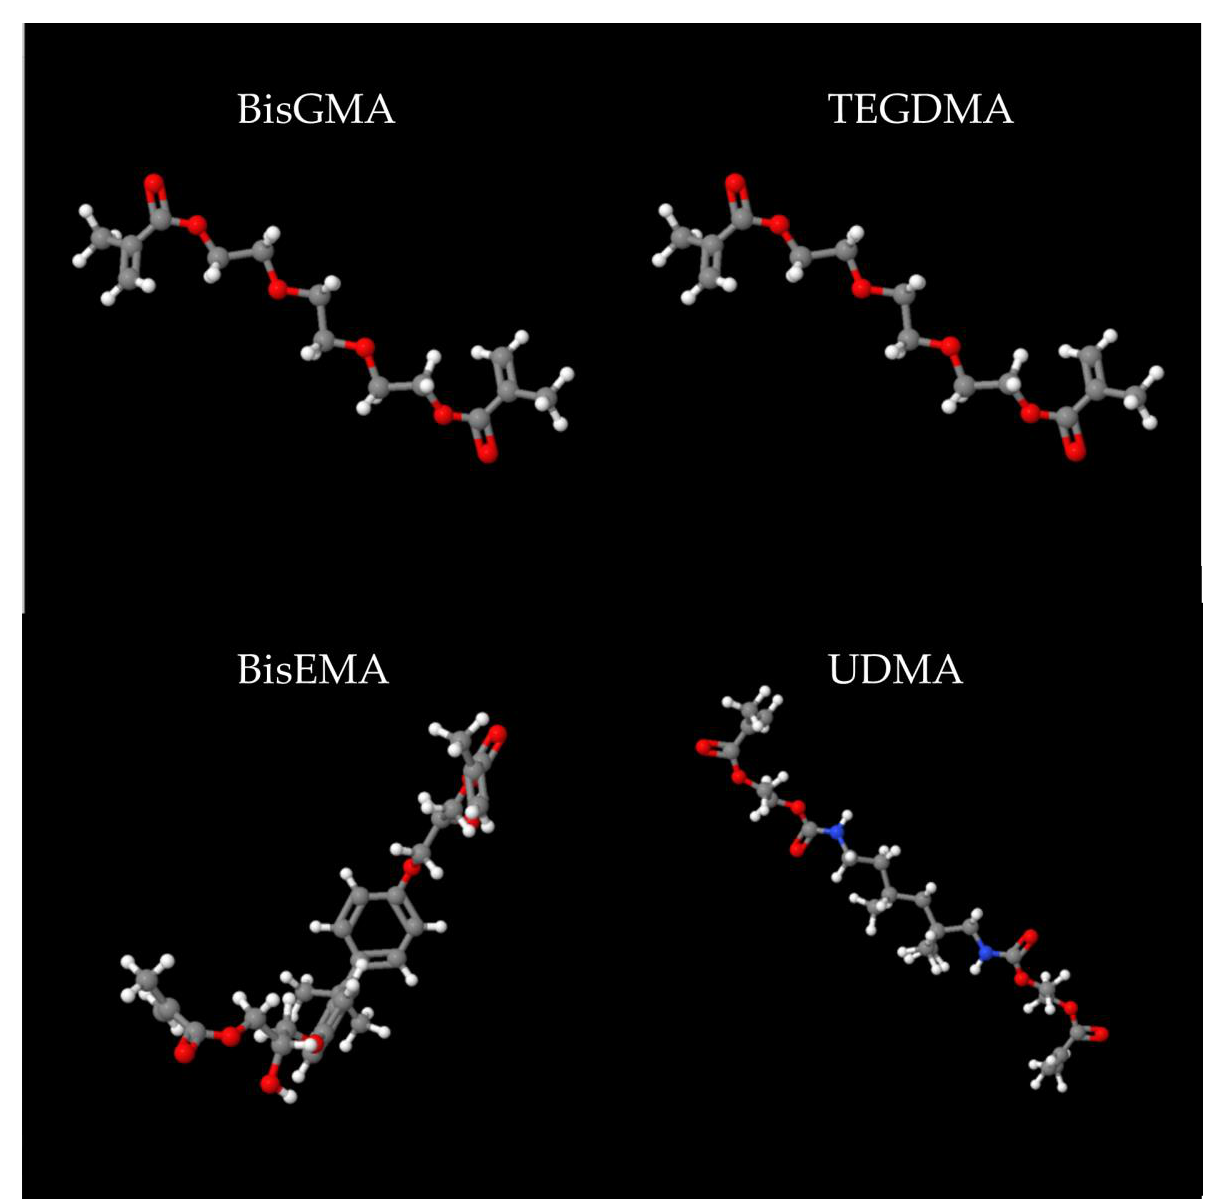
Figure 1. Molecular 3D structure of monomers commonly applied in dental composites. Note: Reprinted from ChemSpider, search and share chemistry.